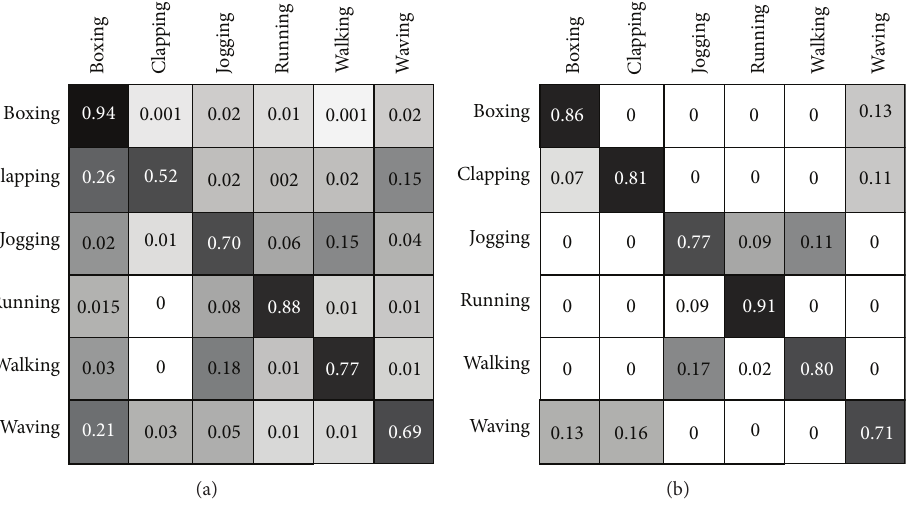
Figure 5: Confusion matrices SNN classifying KTH dataset obtained by adapted active basis model as combination of form and motion pathways. Confusion matrices of the proposed approach have been presented for the case without fuzzy interference system, left matrix, and, after it, right matrix which are achieved from human action movements of KTH dataset [39]. The robustness of the method after adding the fuzzy interference stabilizer is considerably increased. The wrong recognitions in the left confusion matrix have been decreased especially in case of some actions, that is, clapping. Moreover, soar of robustness helps increase the overall accuracy and gives better results in classification of biological movement. The accuracy of categorizations using unbalanced SNN is reached at 86.46%.